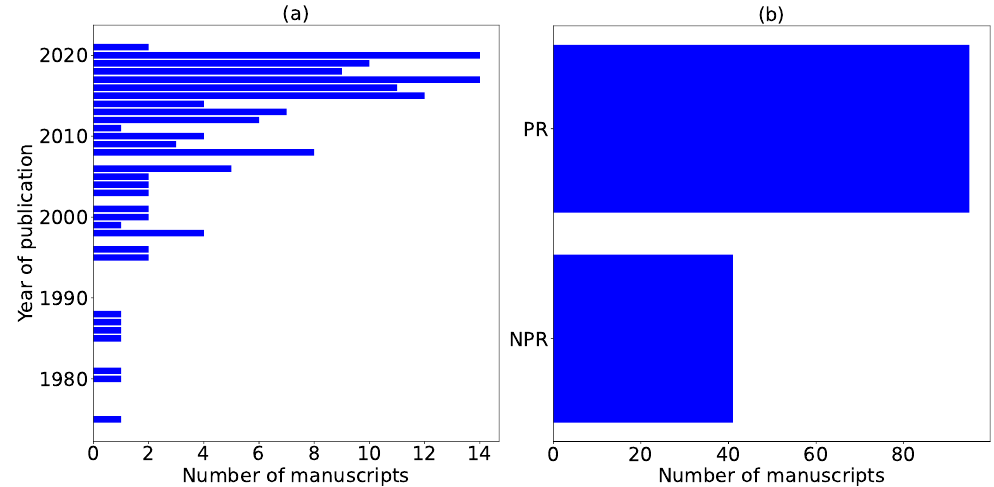
Figure 3. ( a ) Counts manuscripts published per year, and ( b ) summarizes review status of manuscripts, i.e., NPR and PR manuscripts,